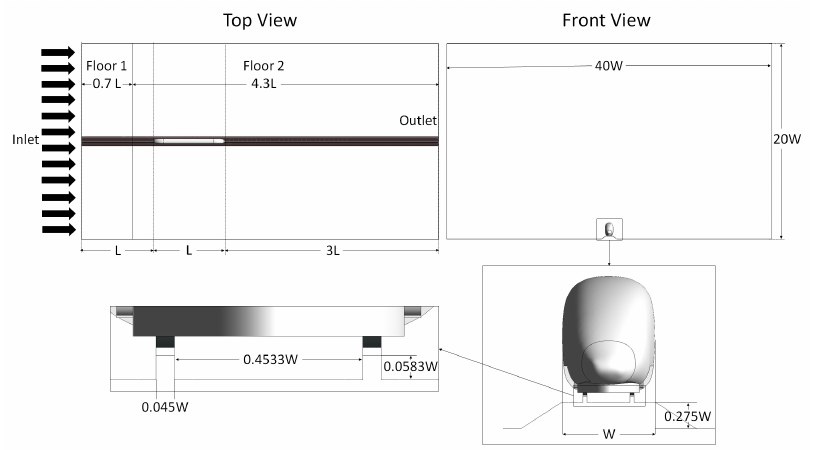
Figure 1. Dimensions and layout of the computational